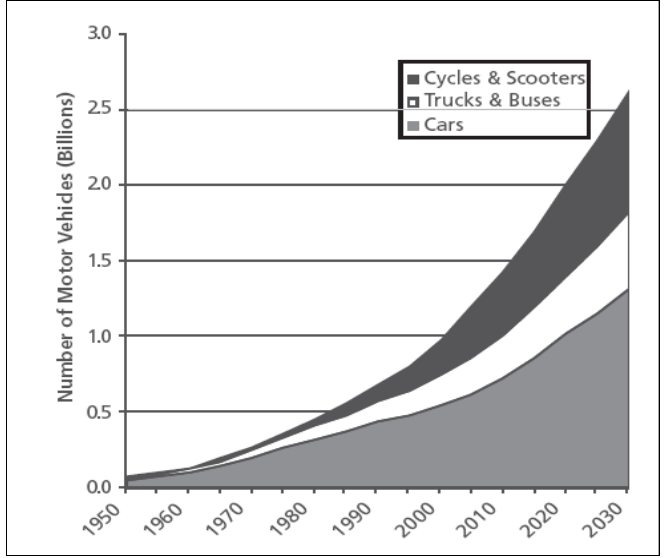
Figure 1. Estimated expansion of world vehicles. Source: Sperling and Gordon